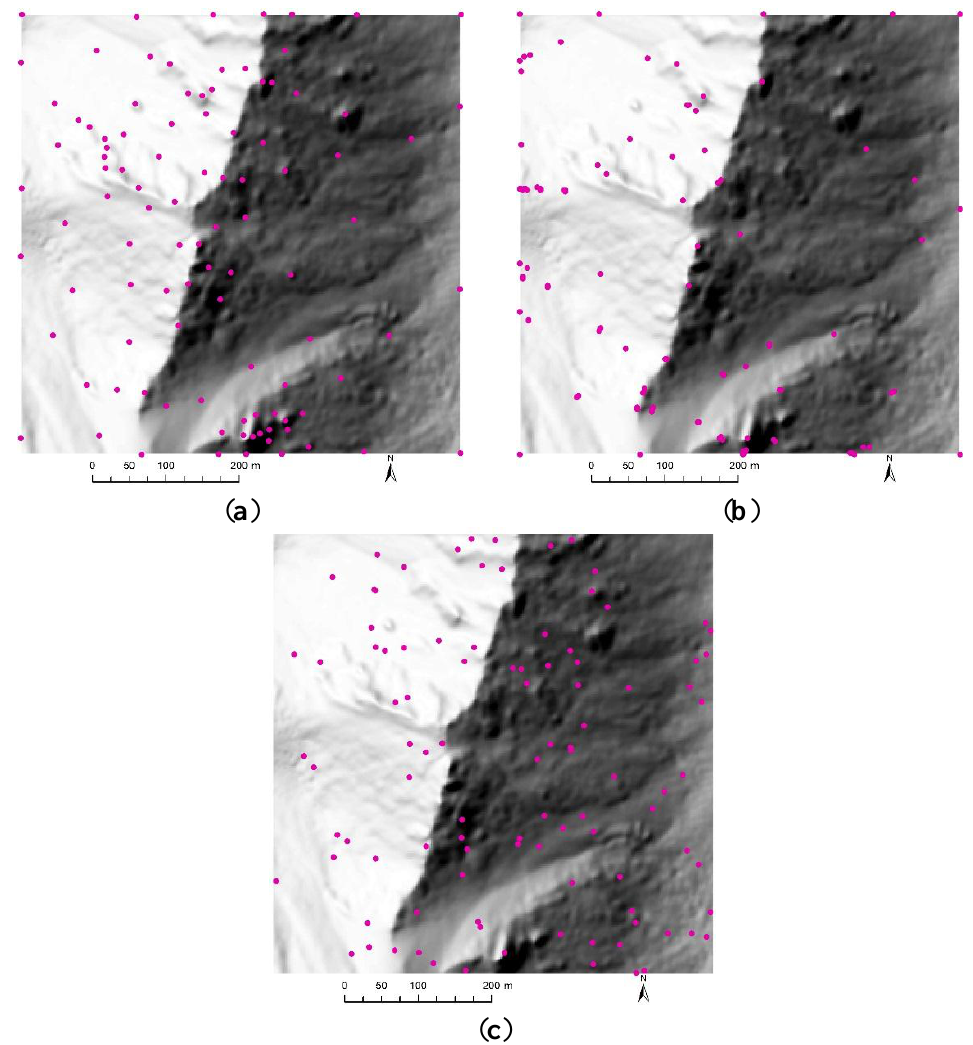
Figure 5. Distribution of the 100 critical points selected by ( a ) TPS-based algorithm, ( b ) max-Z and ( c ) the random method in the mountainous